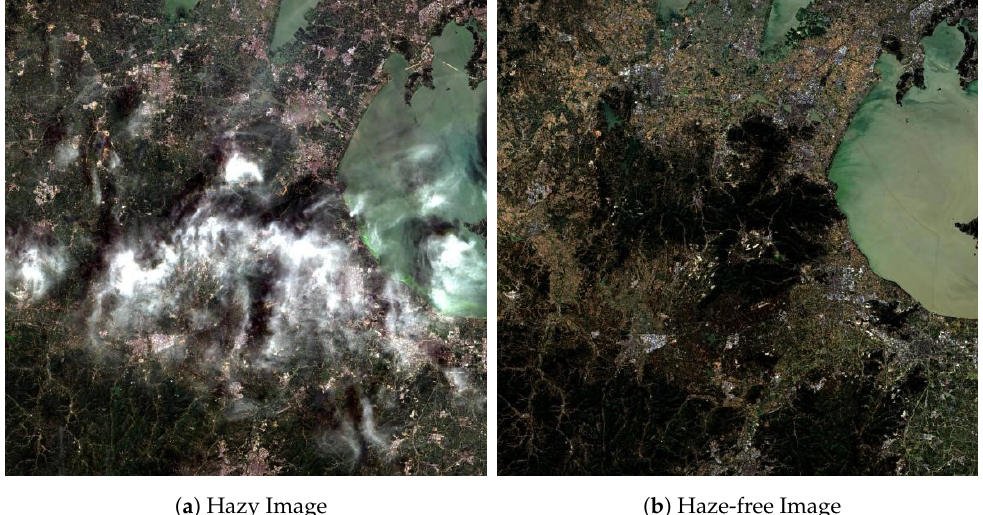
Figure 2. A Sentinel-2 foggy and fog-free image